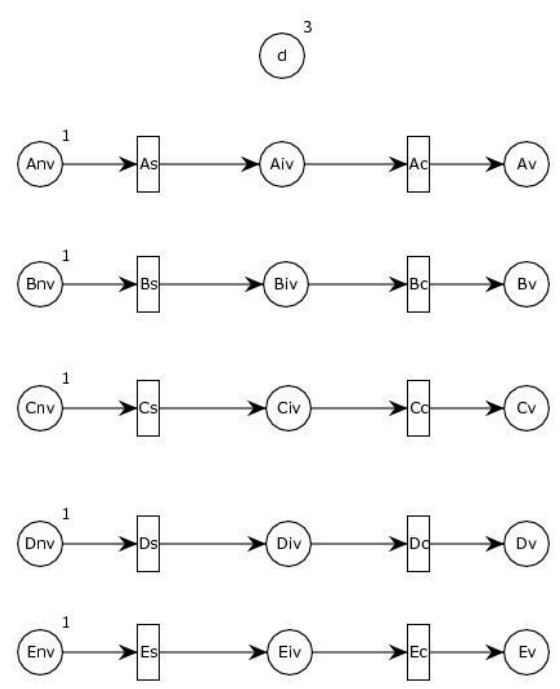
Figure 12. Depo with three salesmen and five cities. Figure 13. Depo with three salesmen and five cities.